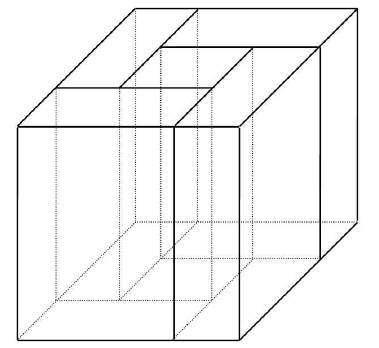
Figure 1: A general tensor partition of a third order